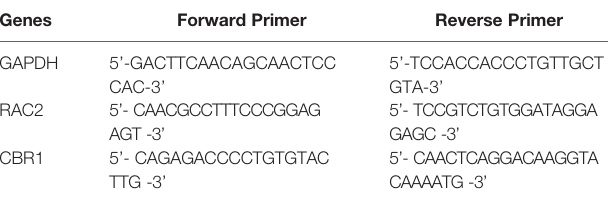
TABLE 1 | Primers used for